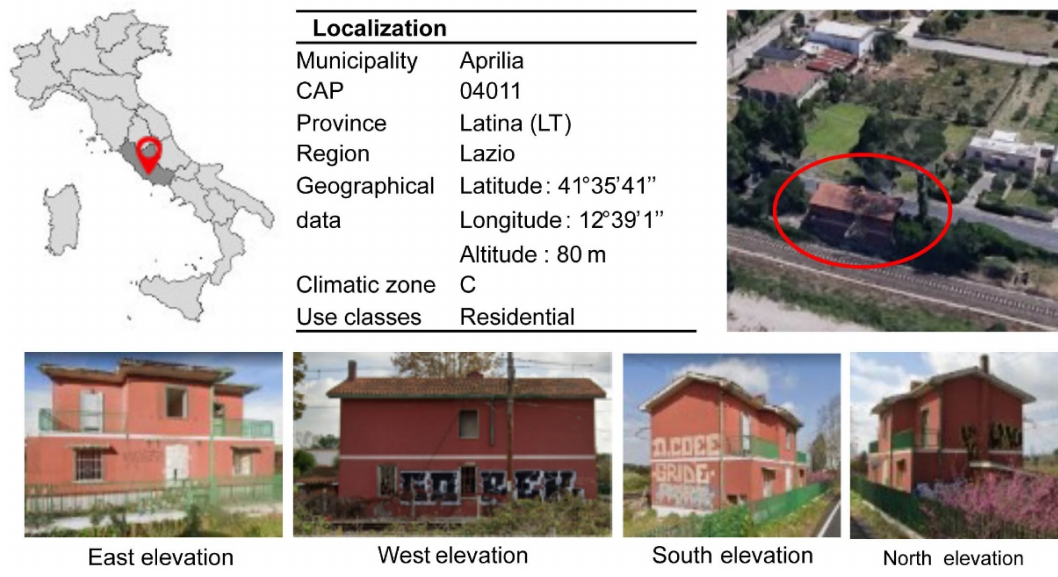
Figure 2. Demonstrator building territorial framing.